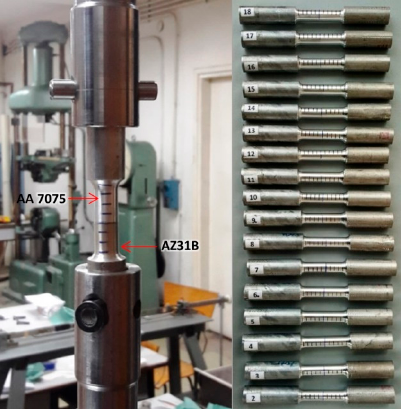
Figure 2. A tensile strength test of the prepared sample.